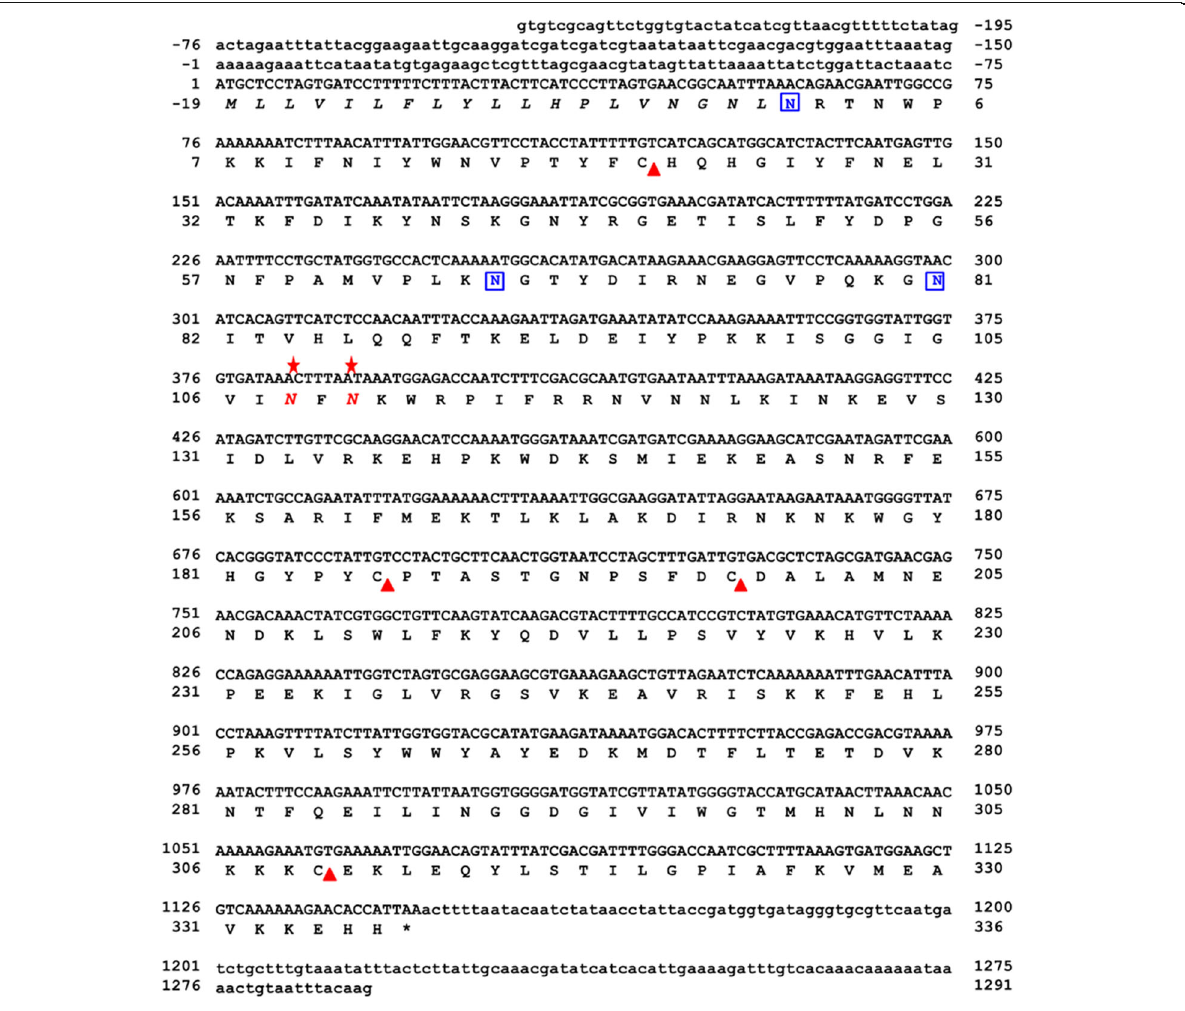
Fig. 3 The completed nucleotide sequence and deduced amino acid sequence of Vespa tropica HAase b (VesT2b). The numbering corresponded to the VesT2b sequence. The 5 ′ and 3 ′ UTRs were indicated by the small letters. Disulfide bonds were labelled with triangle marks ( △ ): (C 21 -C 310 and C 187 -C 199 ). Three potential immunogenic sites were indicated with blue boxes ( ▯